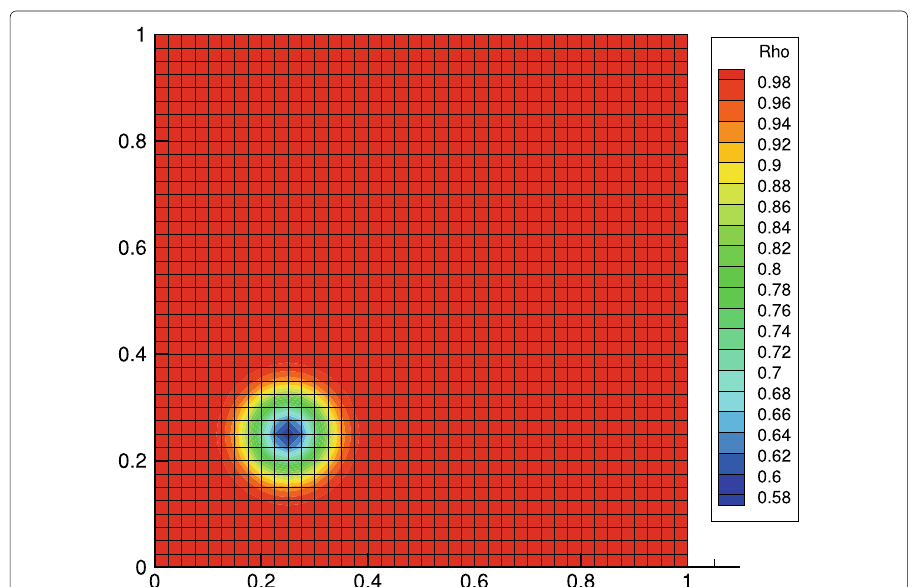
Fig. 3 Initial mesh and density distribution for the isentropic vortex problem